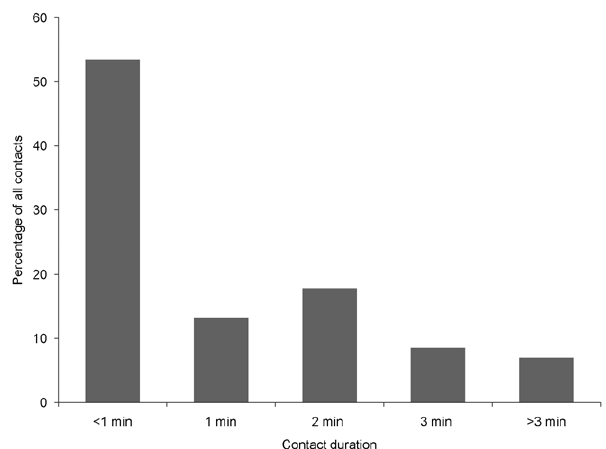
Figure 5. Duration of interactions. Percentage frequency distribu- tion of the length of time shark 365 interacted with other juvenile lemon sharks in the Bone Fish Hole nursery area.